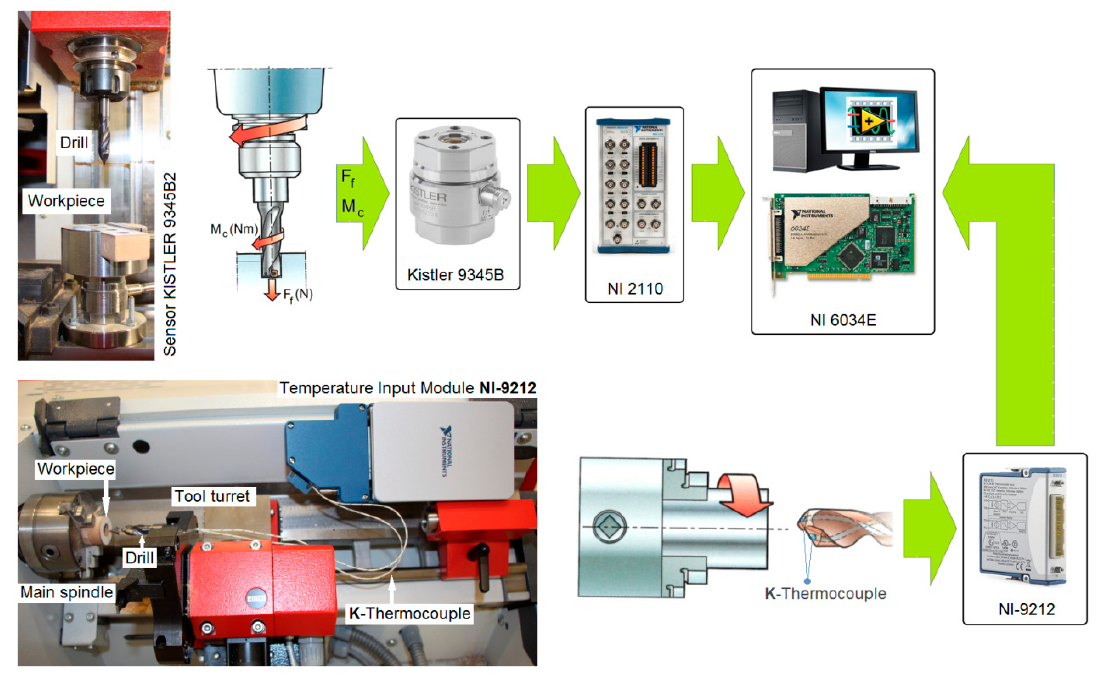
Figure 8. Experimental set-up and schematic diagram of the data acquisition system.